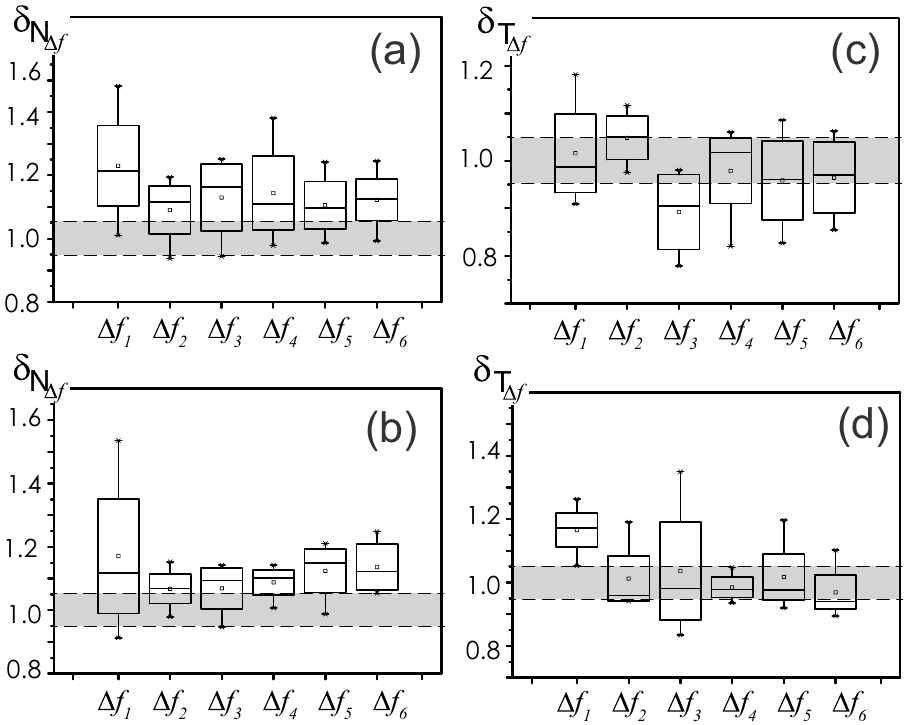
Figure 4. The results of a statistical assessment of the average number N (cid:31) f and the duration T (cid:31) f of oscillatory patterns P for a group of experimental animals: ( a , b )— δ N � ( c,d )— δ T � (2) for the same animal conditions. Band of minor deviations δ [0.95; 1.05] is highlighted in f